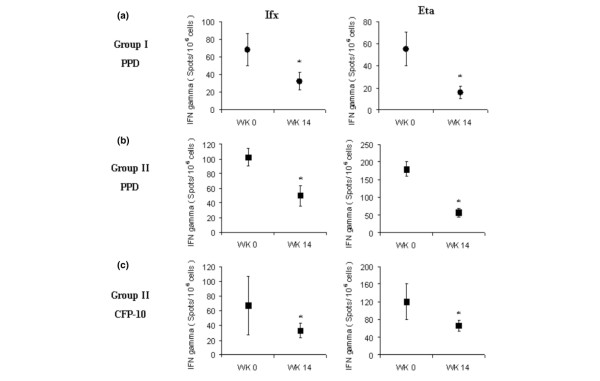
Effect of infliximab (Ifx) and etanercept (Eta) treatment on anti-mycobacterial responses. The effect of 14-week treatment with Ifx or with Eta on interferon (IFN)-γ release induced by purified protein derivative (PPD) in patients from group I, (a) or in patients from group II (b). The effect of 14-week treatment with Ifx or with Eta on interferon (IFN)-γ release induced by culture filtrate protein (CFP)-10 was determined in patients from group II (c). Results are expressed (mean ± standard error of the mean) as number of interferon (IFN)-γ-producing cells per 106 cells. n = 13 and 16 for Ifx and Eta respectively in (a). n = 11 for both Ifx and Eta in (b) and (c). *p < 0.01 for comparisons between week 0 and week 14 (Wilcoxon test).